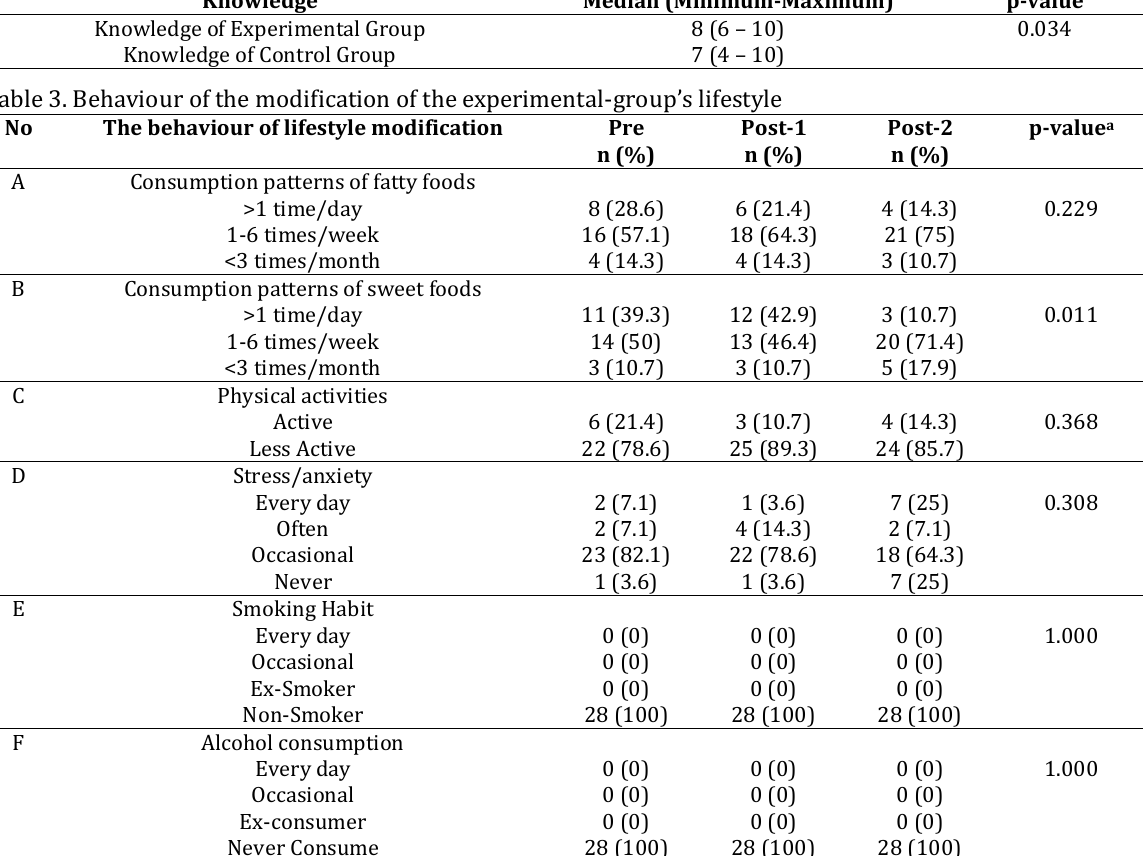
Table 2. Mann Whitney test analysis results: differences in healthy life pattern knowledge between the experimental and control groups.